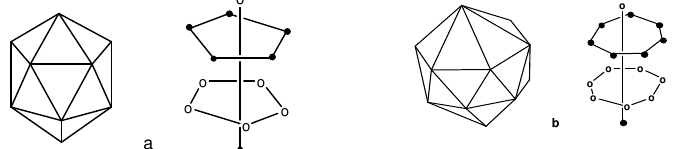
Figure 3. Atomic model for (a) d block and (b) f block